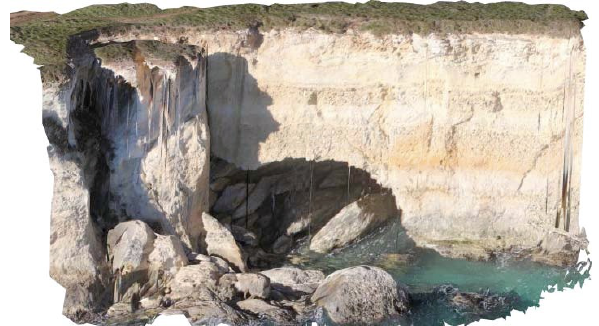
Figure 8: Details of open fractures marked: open fractures (red lines), surface unevenness (yellow line) and crumbling mass (green line). Analysing these measure-